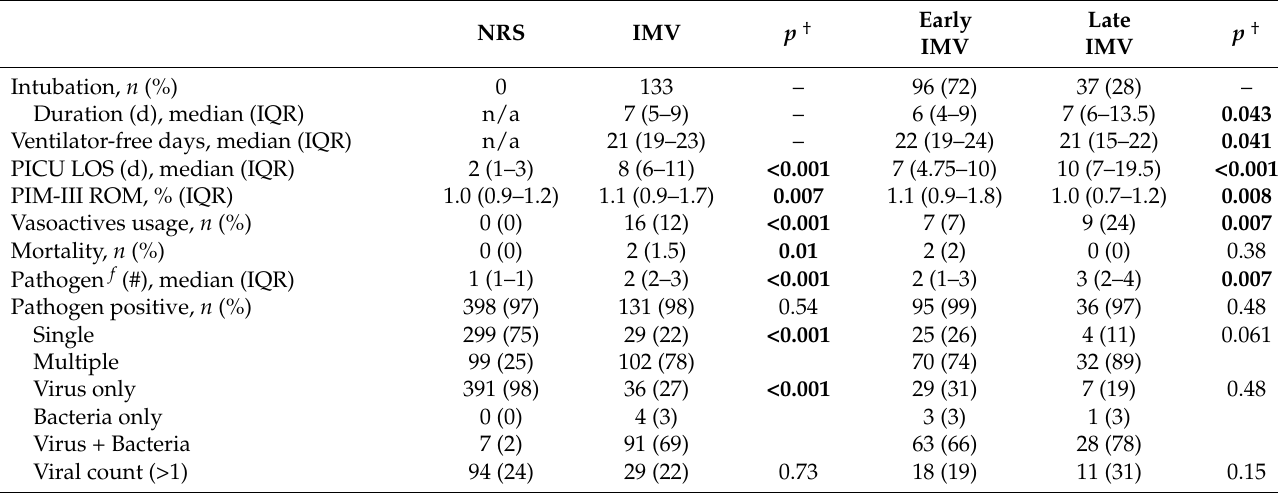
Table 3. Hospital Course and Pathogen Characteristics (all groups, n =